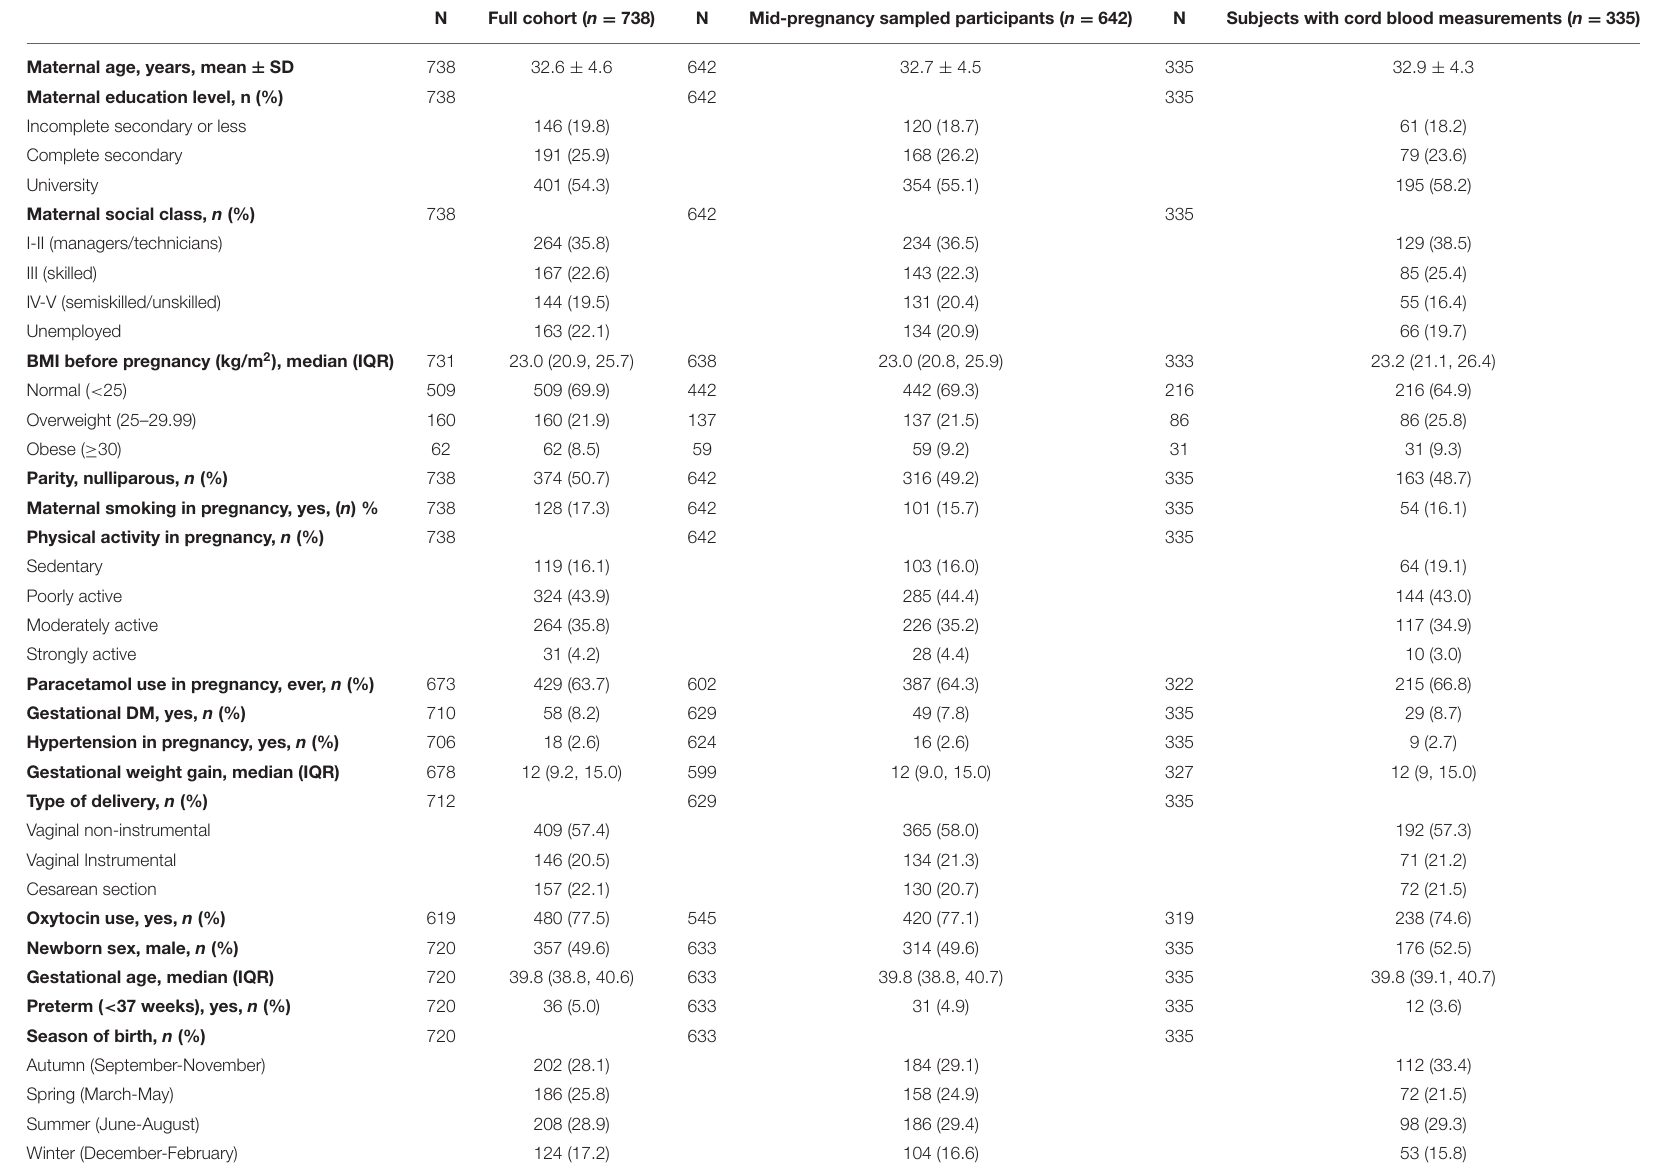
TABLE 1 | Baseline characteristics of the subjects available for maternal dietary patterns in pregnancy and oxidative stress biomarkers measurement at mid-pregnancy ( n = 642) and at birth ( n = 335). The Nutrition in Early Life and Asthma (NELA) study. N Full cohort ( n = 738) N Mid-pregnancy sampled participants ( n =